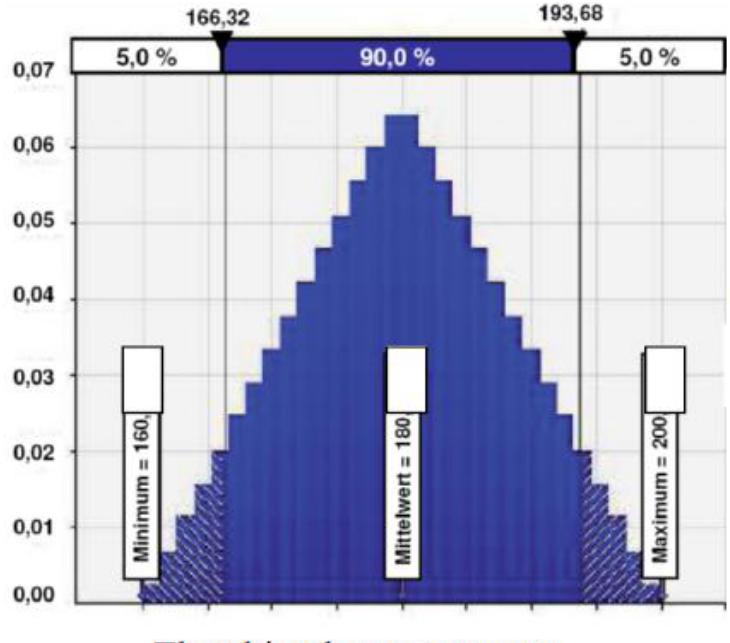
Figure 5. Available threshing hours per year in all regions combine harvesting. Source: [17]; own